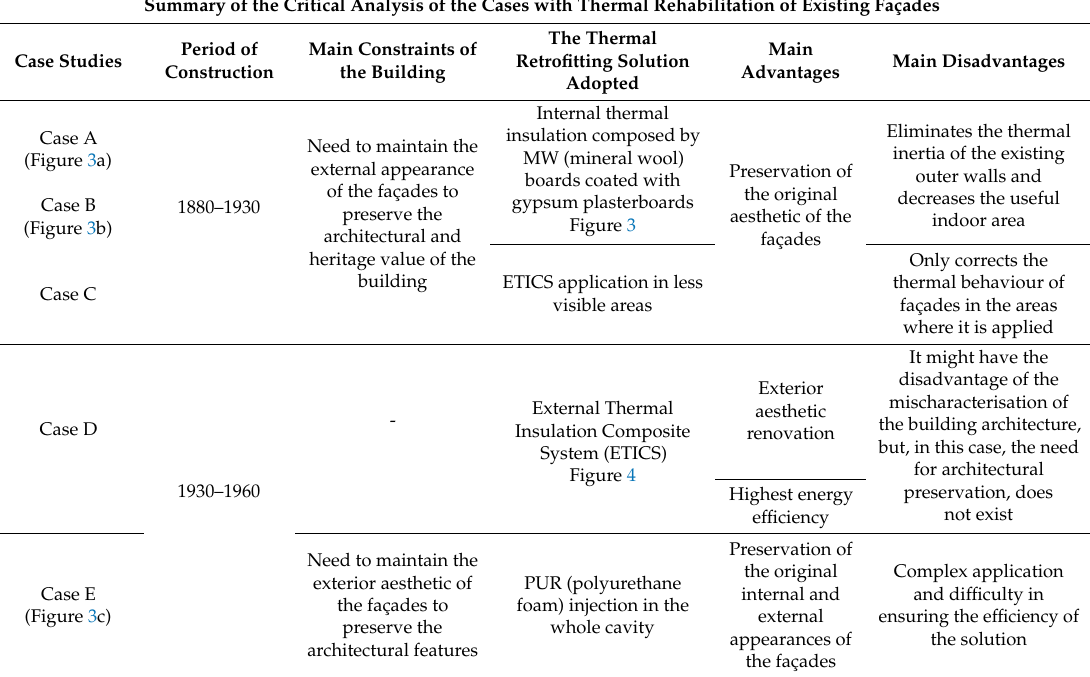
Table 2. Summary of the critical analysis of case studies A to